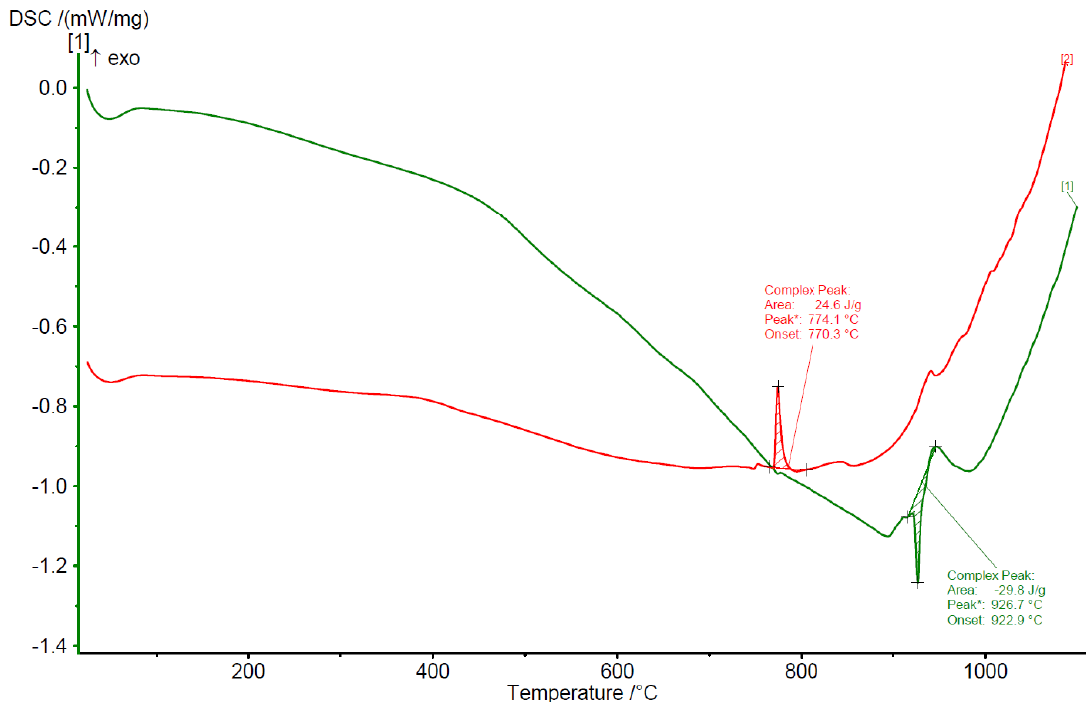
Figure 1. DSC diagram of boron-bearing low-carbon